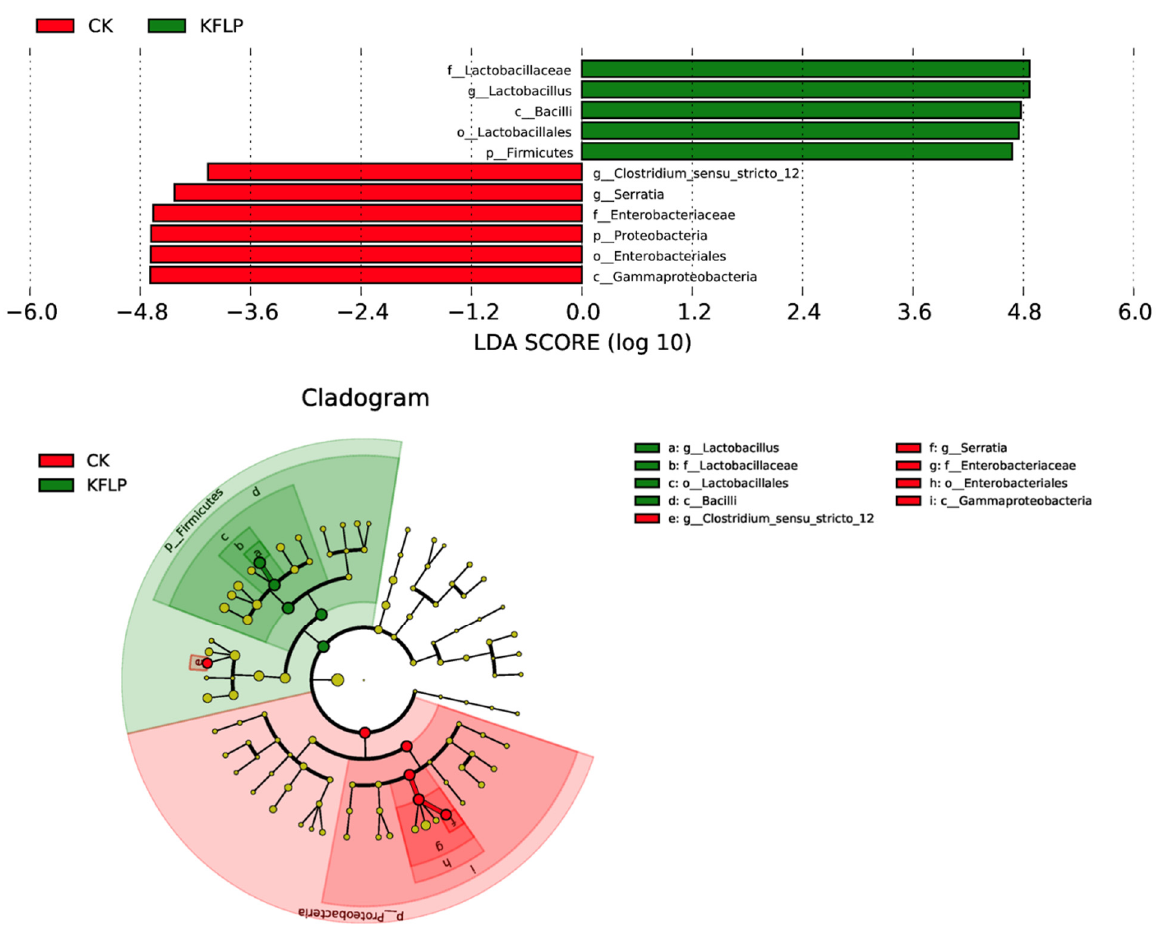
Figure 3. Comparison of bacteria variations using LEfSe analysis. CK: the control; KF: konjac flour; LP: Lactiplantibacillus plantarum ; KFLP: konjac flour + Lactiplantibacillus plantarum .